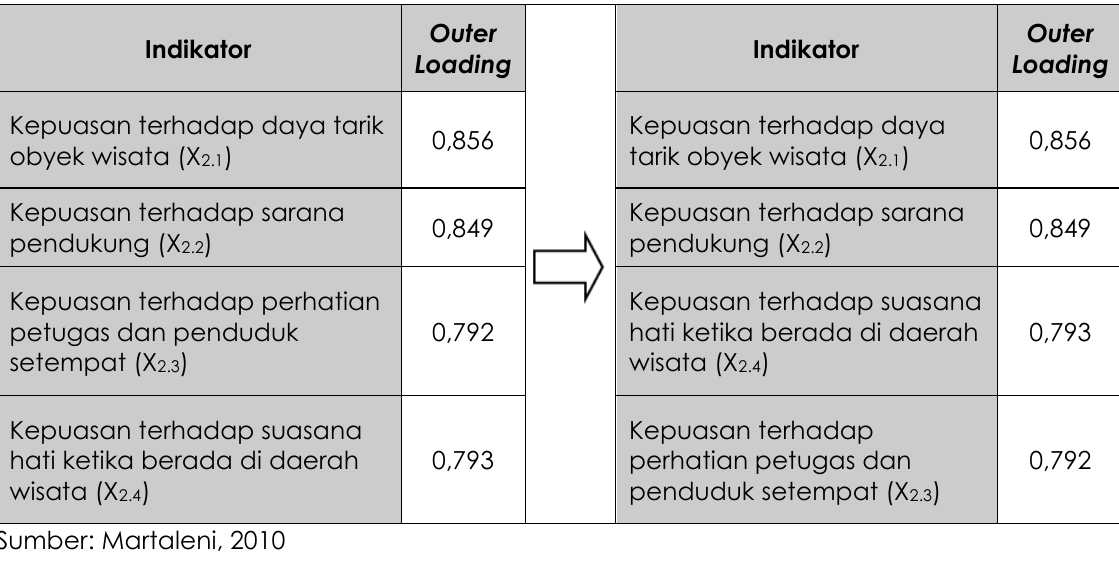
Tabel 3. Hasil loading factor variabel Kepuasan Konsumen